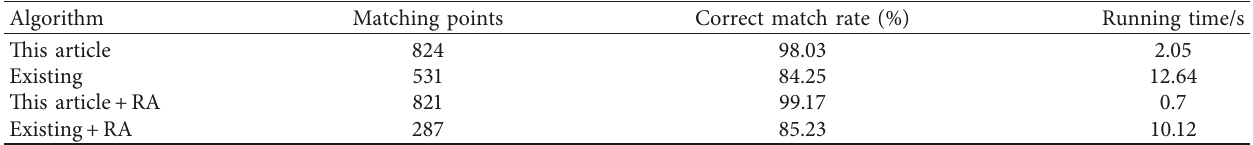
Table 2: Comparison of matching results after image miscut.